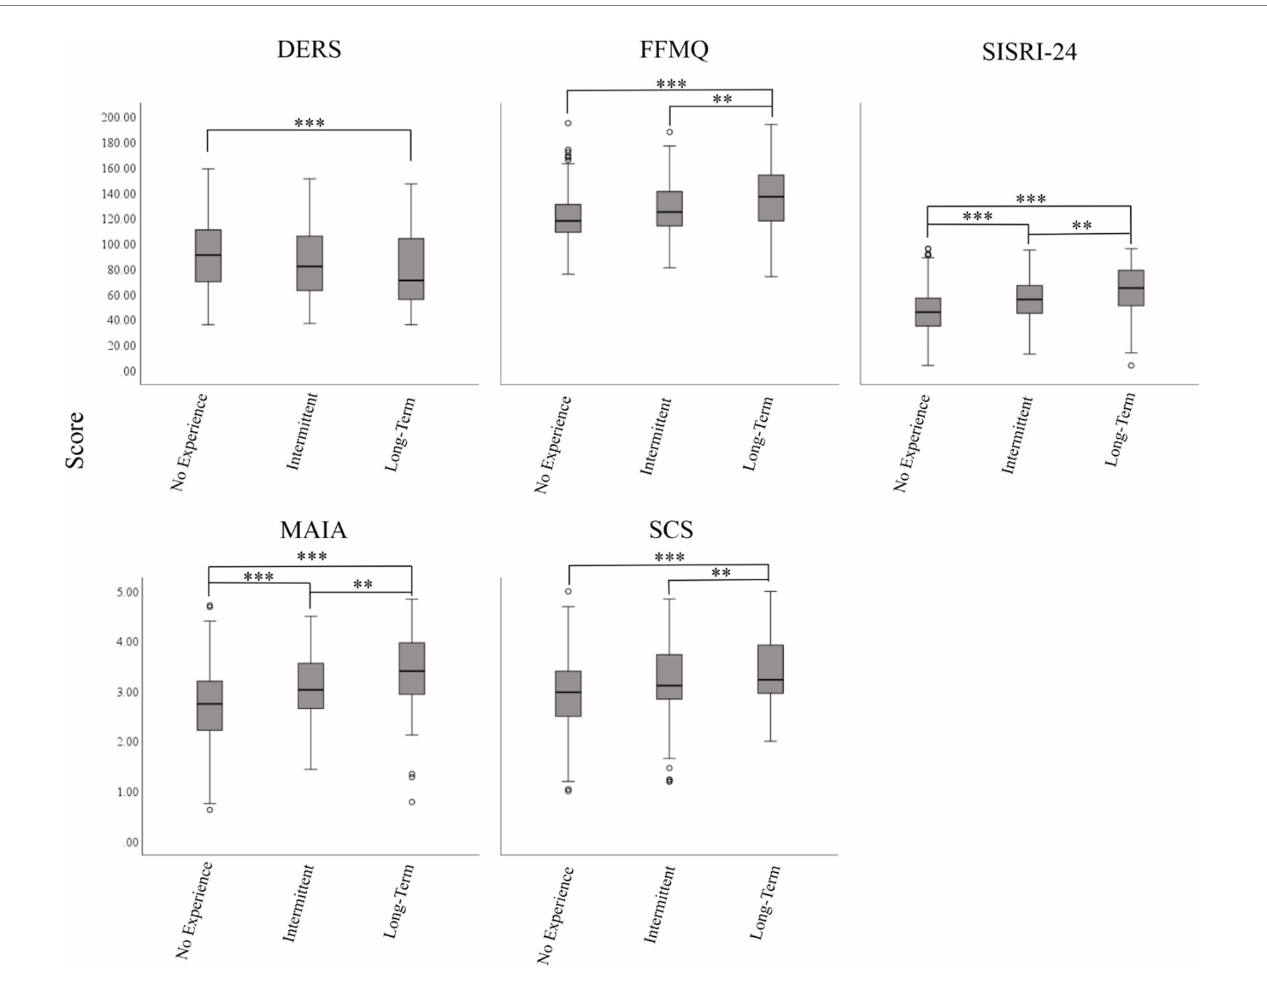
FIGURE 1 ANOVA summary. Margin bars represent ±5% of the mean score. Significance is indicated with ** p < 0.01 and *** p <